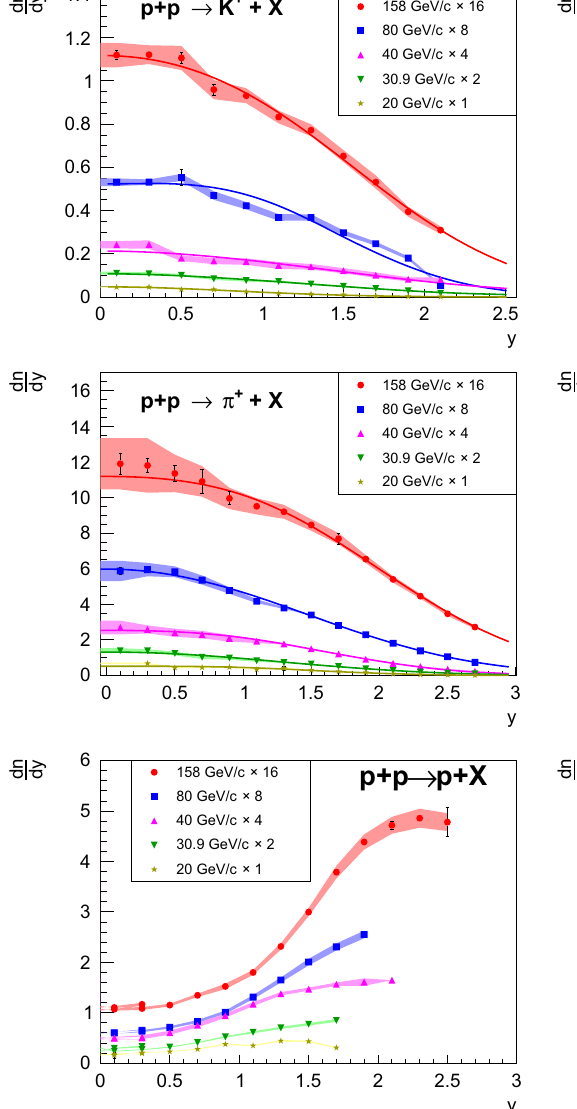
cate statistical, shaded bands systematic uncertainties of the mea- surements. Curves depict Gaussian fits used to determine total multiplicities